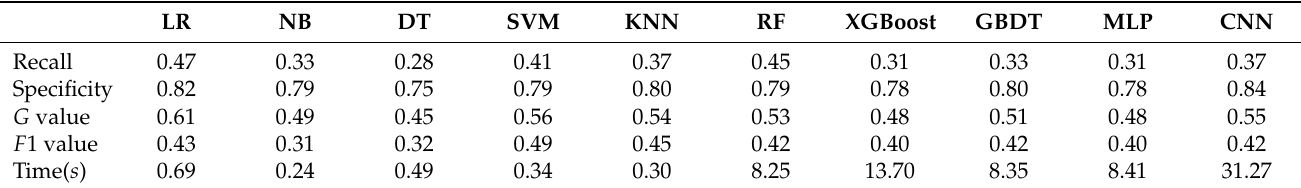
Table 9. Evaluation measures of each machine learning model in the multi-class imbalanced SVD dataset.